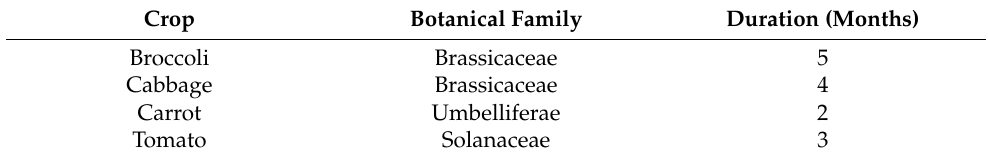
Table 7. Sample of the crops used in Scenario 1 with their botanical family and cultivation duration.